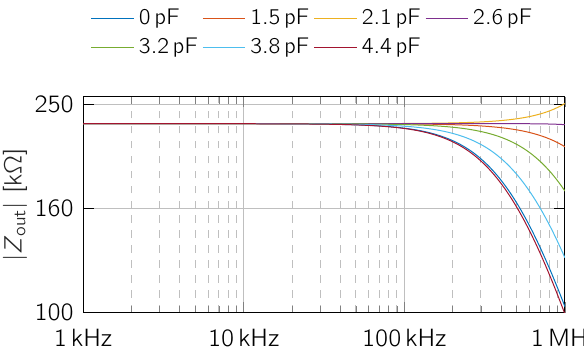
Figure 7: Simulative output impedance of the EHCS with 0.1 % resitor tolerances for various C c : Z out increases with C 2 : 1 pF for higher frequencies. Higher values of C c ≤ reduces the bandwidth of the EHCS.